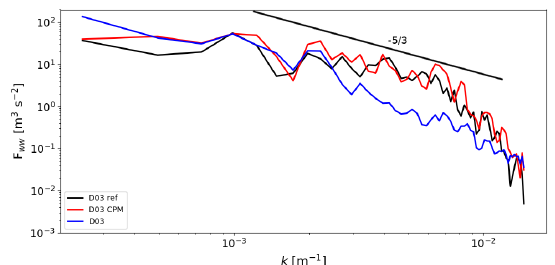
Figure 6. w-spectra taken over diagonal lines and three domains described in Figure 5, averaged over five time samples, beginning at 1900